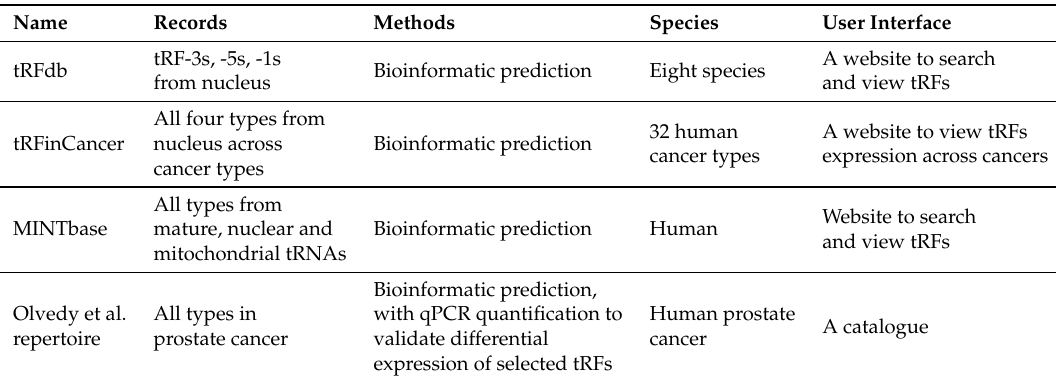
Table 2. List of databases of